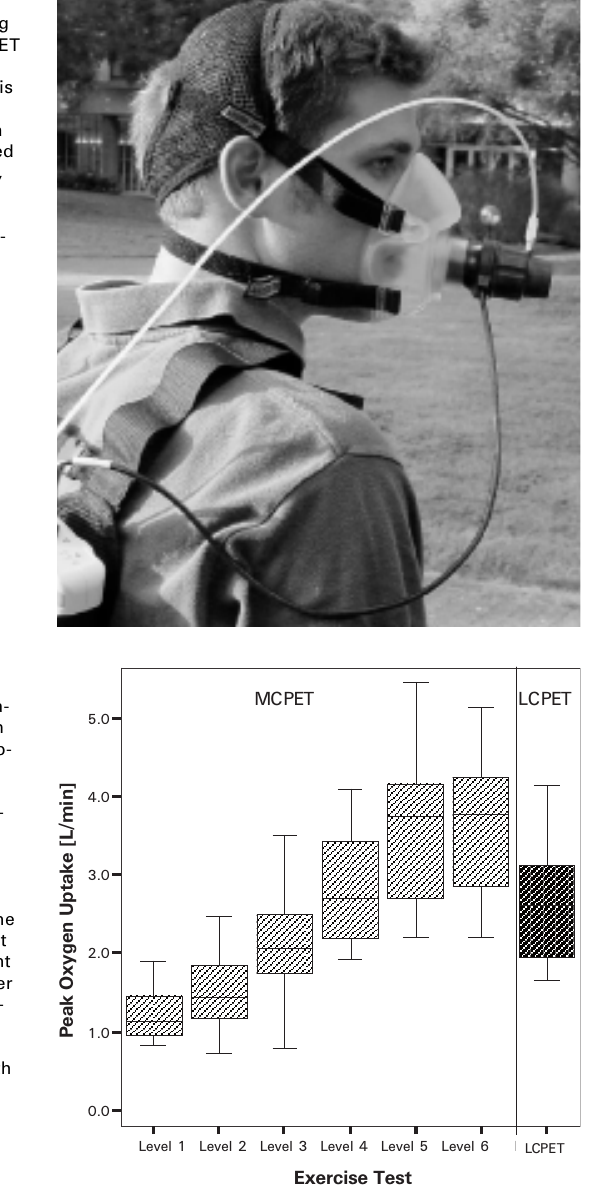
Figure 1 A volunteer wearing the telemetric MCPET device (Oxycon Mobile ® ) used in this study. The mobile device consists of a face mask connected to a volume sensor, a gas analyzer, a polar belt (not visi- ble), a portable sen- sor unit, and data storing unit. The equipment weighs 950 grams.